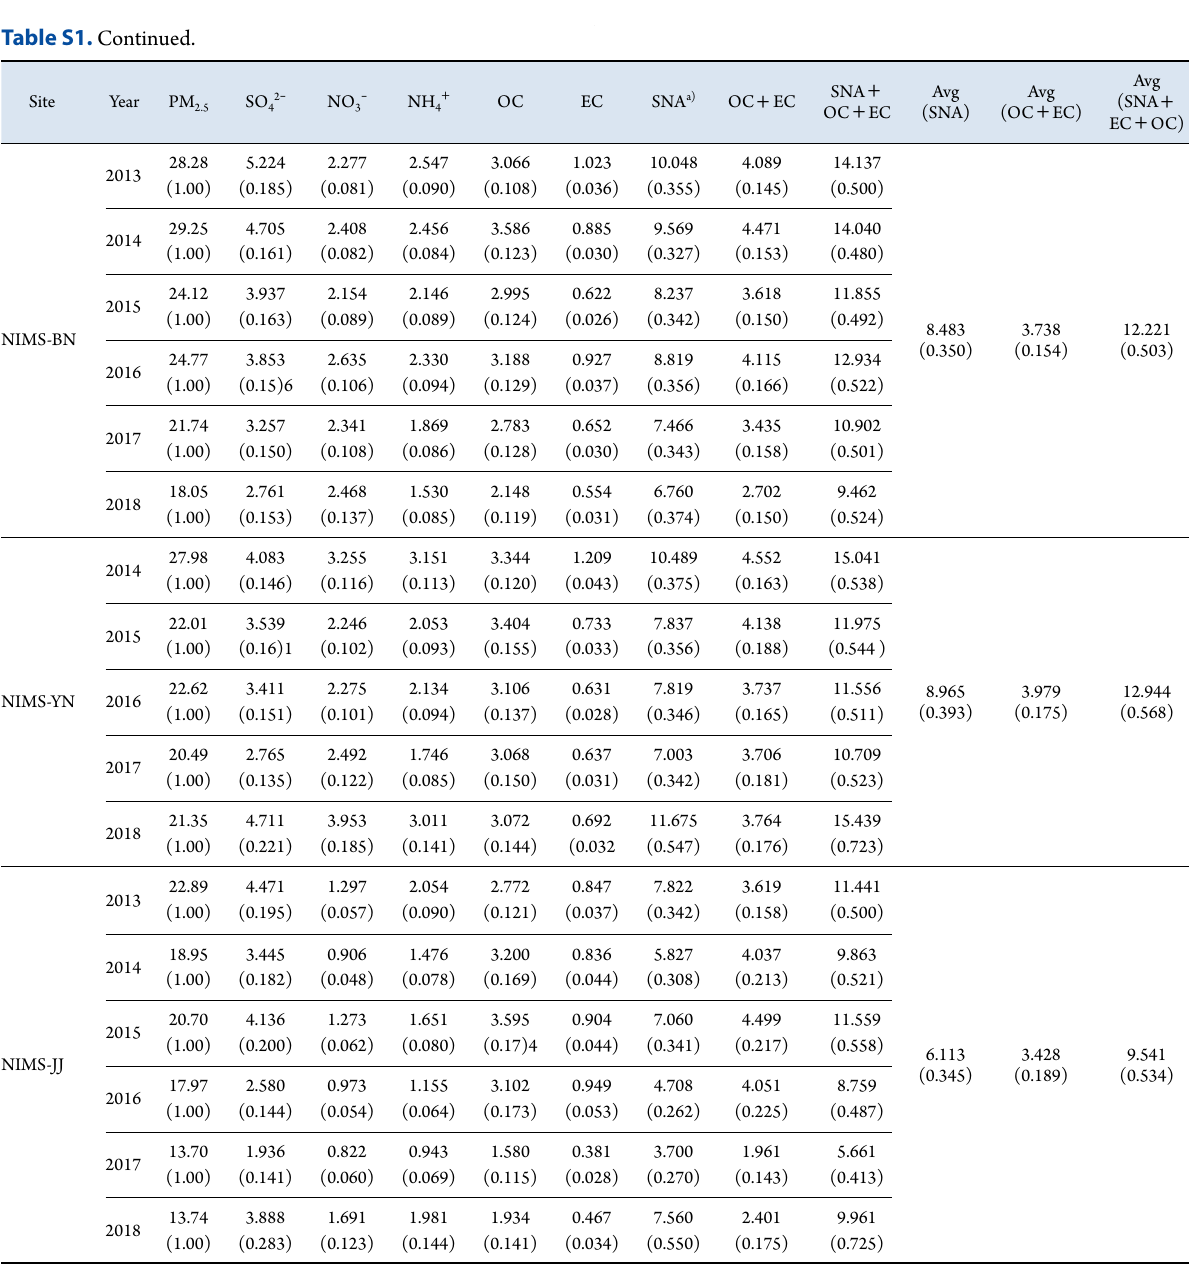
Table S1. Overall summary of annual average concentrations (μg/m 3 ) and mass ratios for 5 major chemical species (Study-2).